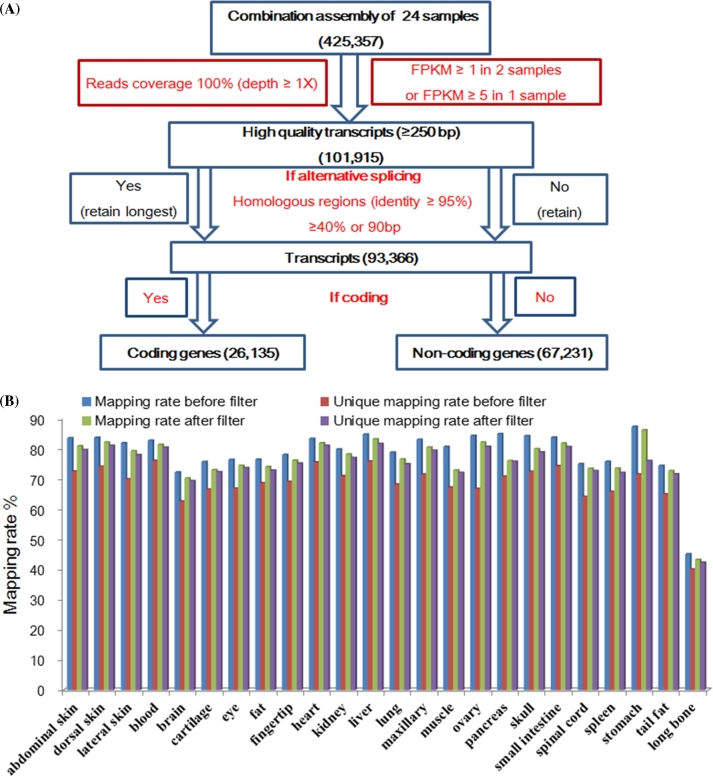
Huge RNA-seq data assembly. (A) The pipeline for de novo assembly, quality filter, and gene identification and classification. (B) The statistics of mapping rate before and after transcript filter. Among the total mapped reads, the unique mapped reads were >98% and the multiple mapped reads were <2% after transcript filter, except sample ‘stomach.’ Moreover, the total mapping rate was a slight decrease in comparison to the result before filter.